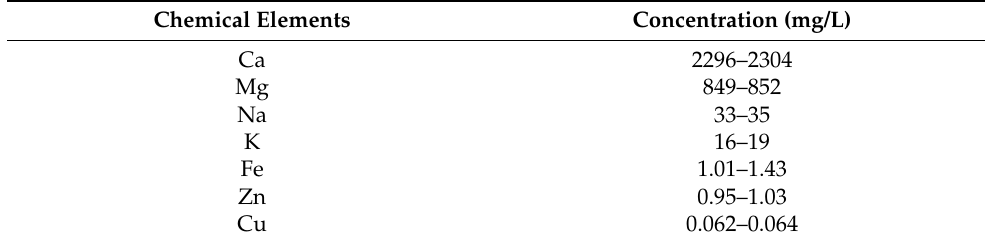
Table 4. The chemical composition of chicken eggshells.